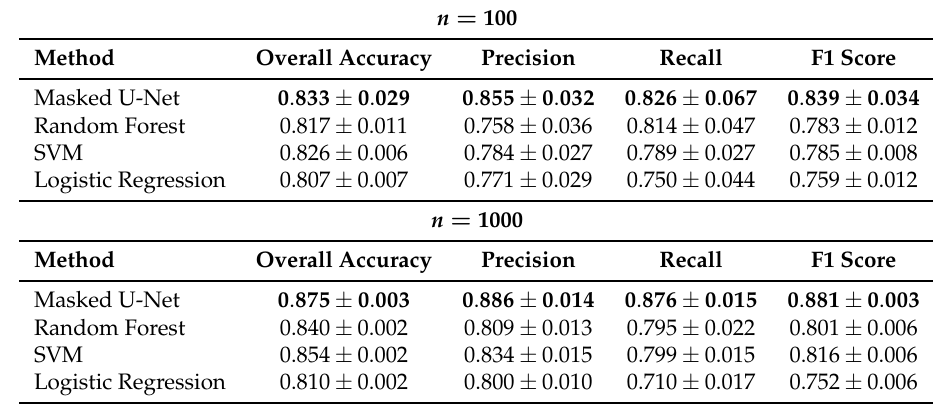
Table 2. Test set accuracy, precision, recall, and F1 scores for the masked U-Net and baselines trained on pixel labels at training set size n = 100 and n = 1000. Bolded numbers display the highest value in each